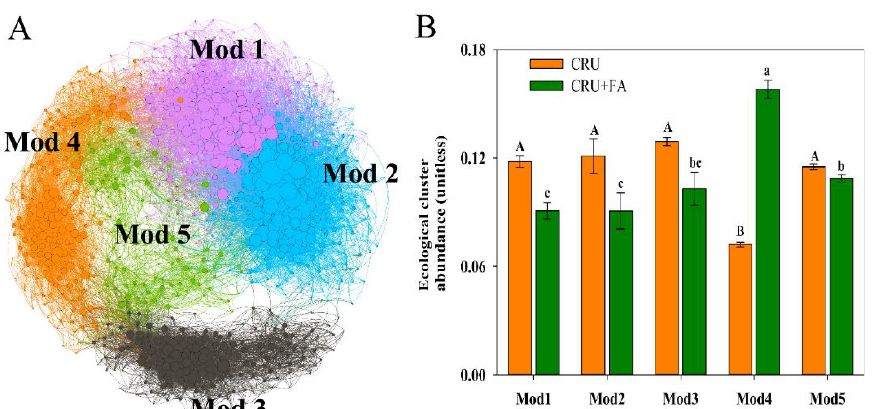
Figure 3. Microbial network diagram with nodes (taxa) colored by each of the major five ecological clusters (modules, Mod) of bacterial communities ( A ); the relative abundance of the five modules ( B ). Capital letters indicate significant differences between the CRU treatment on different modules ( p < 0.05). Lowercase letters indicate significant differences between the CRU+FA treatment on different modules ( p < 0.05).